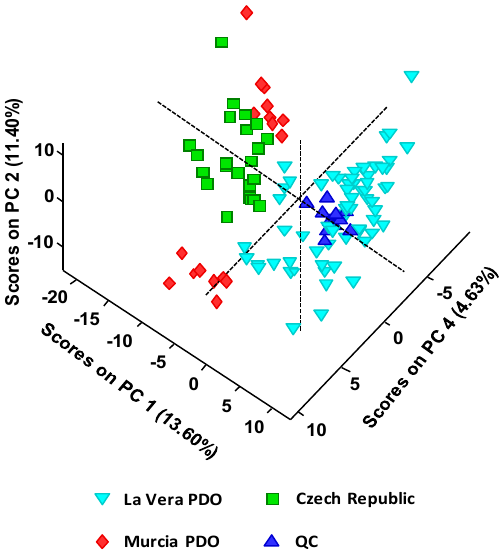
Figure 2. PCA 3D score plot of PC1 vs. PC2 vs. PC4 when UHPLC-HRMS fingerprints were employed as chemical descriptors for the classification of the analyzed paprika samples according to their PDO and production region.